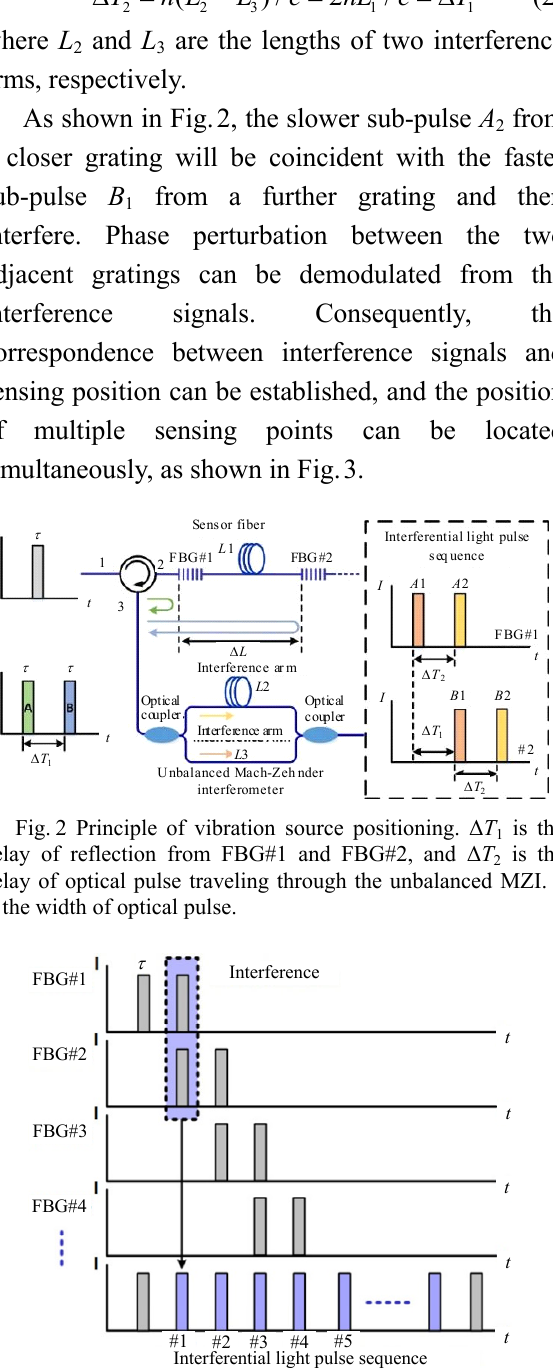
Fig. 3 Relationship between the interferential light pulse sequence and sensing position. The first and last optical pulses of sequence are useless to record vibration. #1 to #5 are the serial numbers of sensing fiber segments,